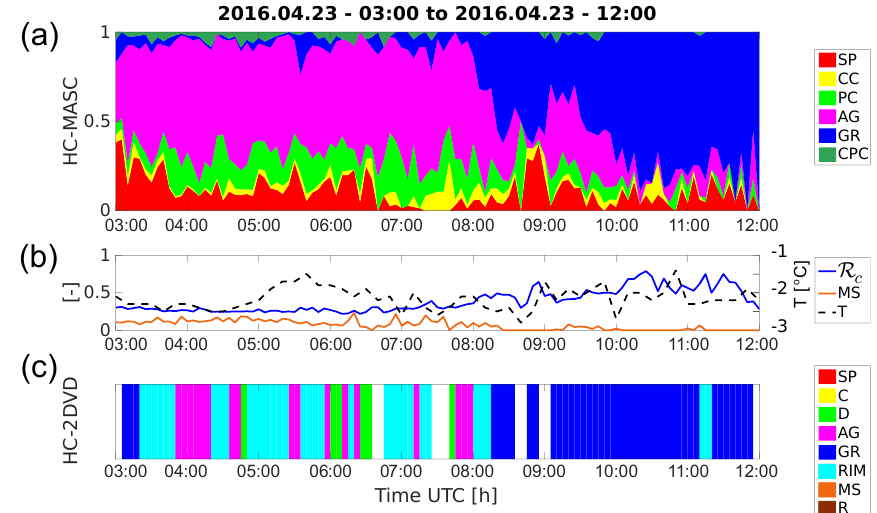
Figure 13. Illustration of the MASC and 2DVD hydrometeor classification comparison during a precipitation event recorded on 23 April 2016. Time series of (a) proportions of each hydrometeor type as classified with the MLR model applied on MASC data; (b) on the left axis: averaged riming index R c ∈ [ 0 , 1 ] and proportion of melting snowflakes MS ∈ [ 0 , 1 ] ; on the right axis: ambient temperature T , as measured by a weather station located in the DFIR; and (c) dominant hydrometeor type recorded by a 2DVD using the method described in Grazioli et al. (2015). On each panel, data were aggregated on time intervals of 5min.